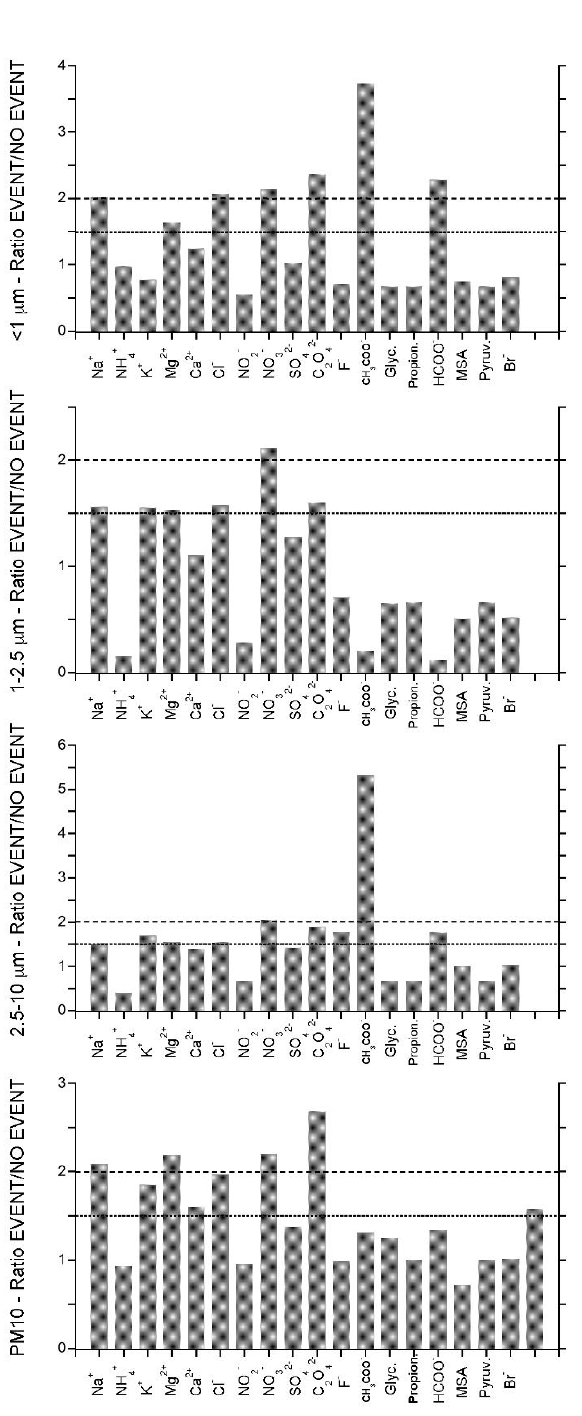
Figure 5. Ratios between average concentration of each determined chemical species and PM 10 load in bulk and size-segregated aerosol during the event (20–23 August 2017) and in the rest of the month. The dotted line marks increases of 50%, while the dashed line indicates 100% enhancements.